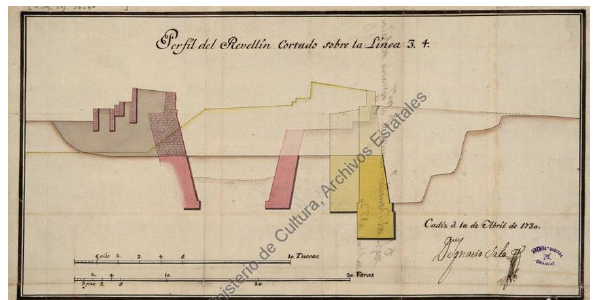
Figure 14. Plan of one section of the ravine projected by Ignacio Sala, AGS. Secretariat of War, Legajos,